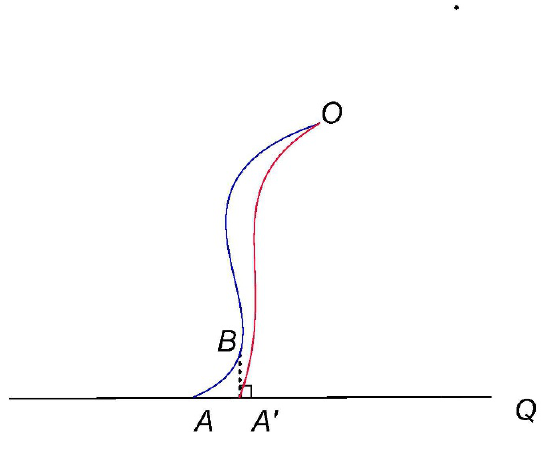
Figure 1 . OBA > OBA 0 > OA 0